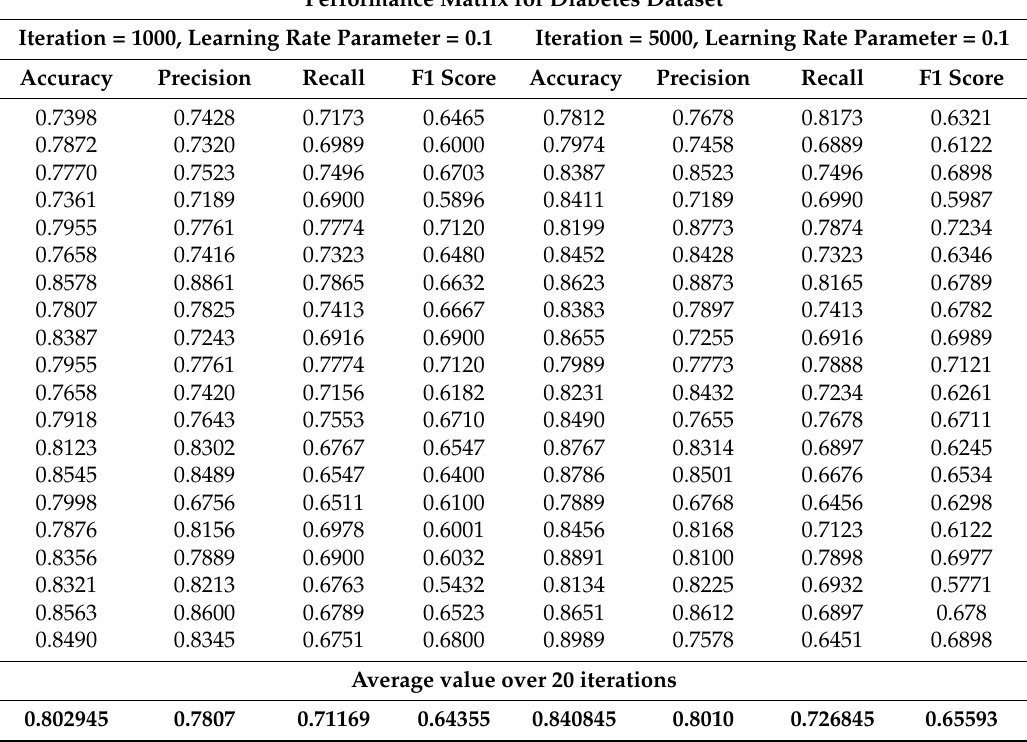
Table 5. Performance matrix for diabetes mellitus prediction. Performance Matrix for Diabetes